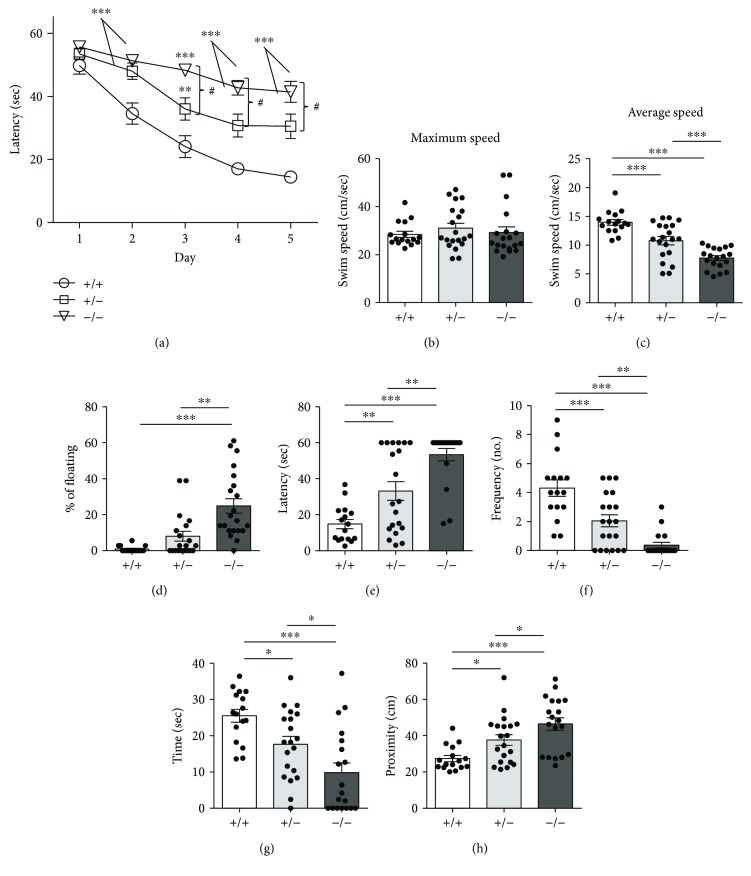
Impaired hippocampus-dependent learning and memory in Cdkl5 +/− female mice. (a) Spatial learning assessed using the Morris water maze. Cdkl5 +/− (n = 20) and Cdkl5 −/− (n = 19) mice showed an increased latency to find the platform over the 5-day learning period compared to the Cdkl5 +/+ (n = 16) mice. (b, c) Maximum (b) and average (c) swim speed during the learning phase in mice as in (a). (d) Percentage of floating, defined as the percentage of time swimming at less than 4 cm/s during the learning phase in mice as in (a). (e–h) On day 6 (probe test), the platform was removed and spatial memory was assessed by evaluating different parameters. Cdkl5 +/− and Cdkl5 −/− mice showed an increased latency to enter the former platform zone (e), a reduced frequency to enter (f), and time spent in the quadrant (g) in which the platform had been located during the learning period. In addition, Cdkl5 +/− and Cdkl5 −/− mice swam a larger distance from the former platform (h) compared to the Cdkl5 +/+ mice, indicating defects in spatial memory. Values represent mean ± SEM. ∗
p < 0.05, ∗∗
p < 0.01, and ∗∗∗
p < 0.001 as compared to the Cdkl5 +/+ female mice; #
p < 0.05 as compared to the Cdkl5 +/− female mice (dataset in a); ∗
p < 0.05, ∗∗
p < 0.01, and ∗∗∗
p < 0.001 as compared to the Cdkl5 +/+ or Cdkl5 +/− female mice (dataset in b–h), Fisher's LSD test after ANOVA; datasets in (d), Dunn's test after Kruskall-Wallis).